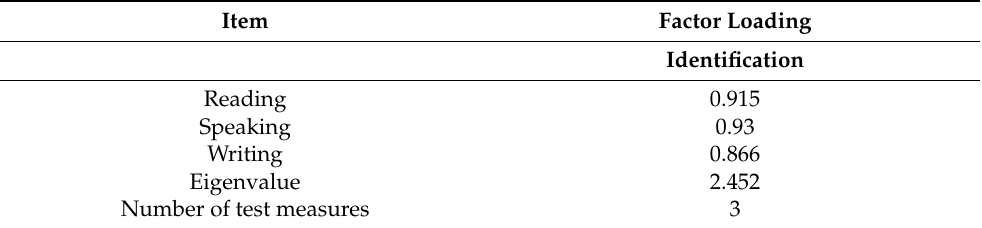
Table 6. Summary of results from exploratory factor analysis of Japanese